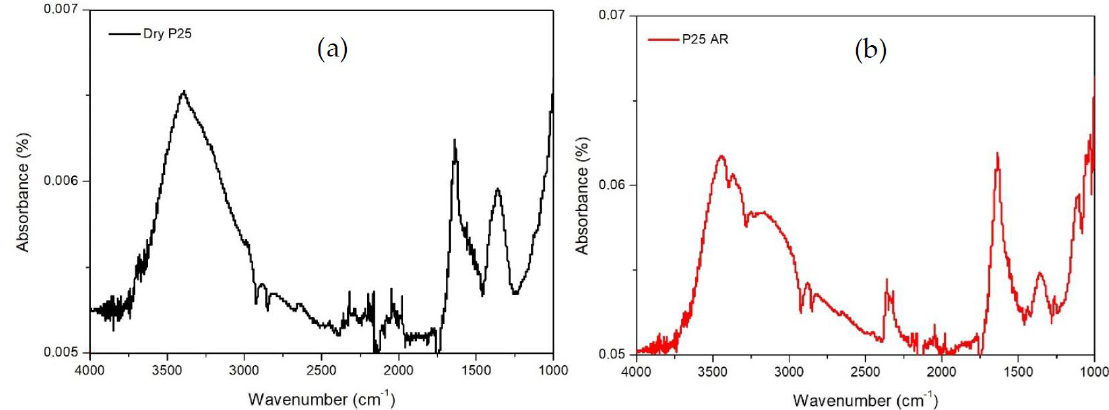
Figure 9. Attenuated Total Reflectance Fourier-Transform Infrared Spectroscopy (ATR-FT-IR) spectra of ( a ) P25 powder before reaction, ( b ) P25 analyzed after the PR reaction.